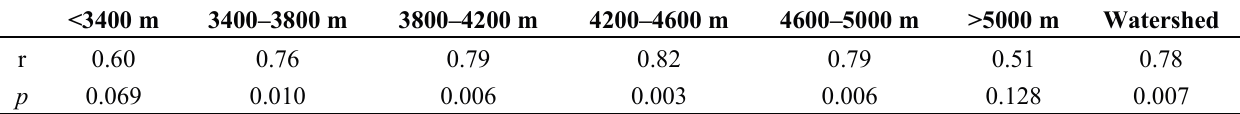
Table 2. Correlation between annual stream flow and the SCPs in different elevation